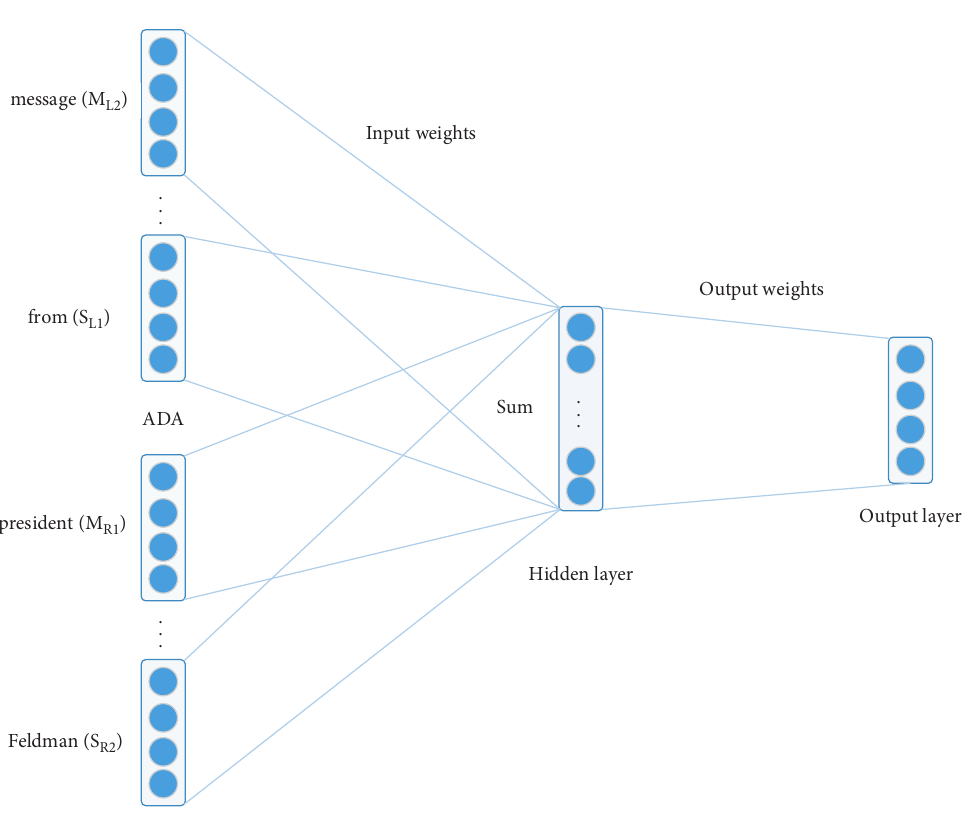
Figure 2: CBOW model of